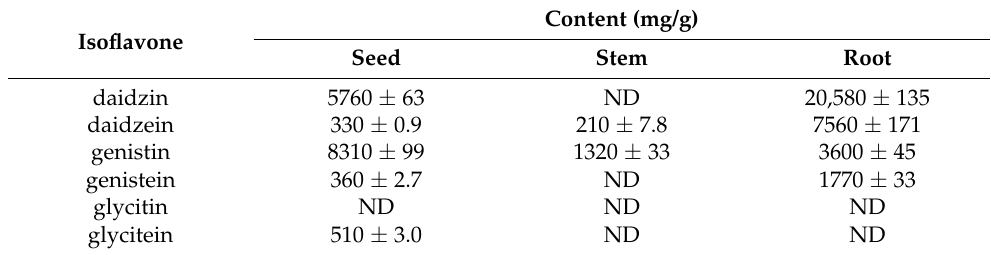
Table 2. Isoflavone contents in 10% ( w / v ) seed, stem, and root extracts of Korean wild soybean a .